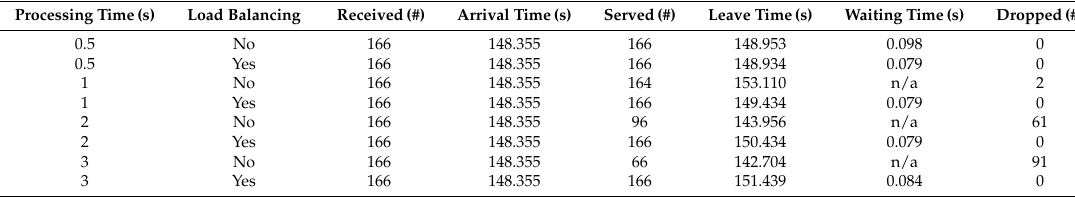
Figure 10. The load balancing implemented in IoV. ( a ) Traffic network in Erlangen. ( b ) SDN network. Table 4. The waiting time and the report